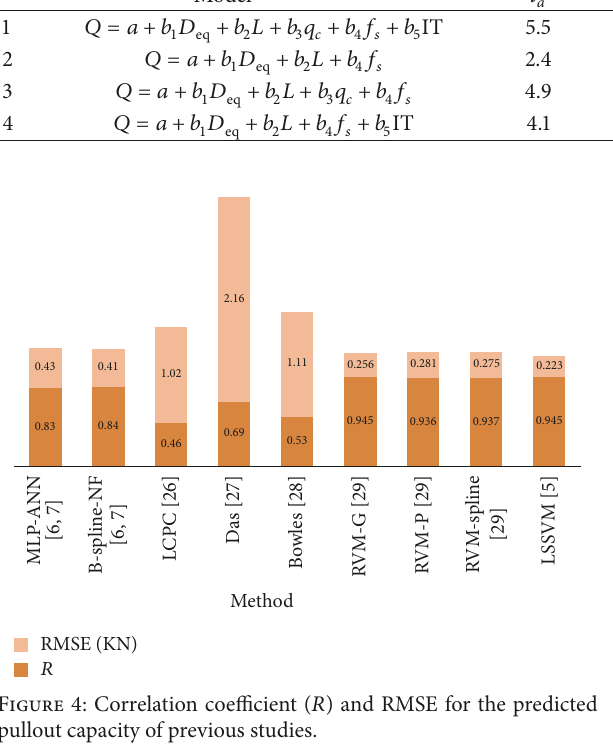
Table 3: Linear trend component and coefficient test for the regression models. Model